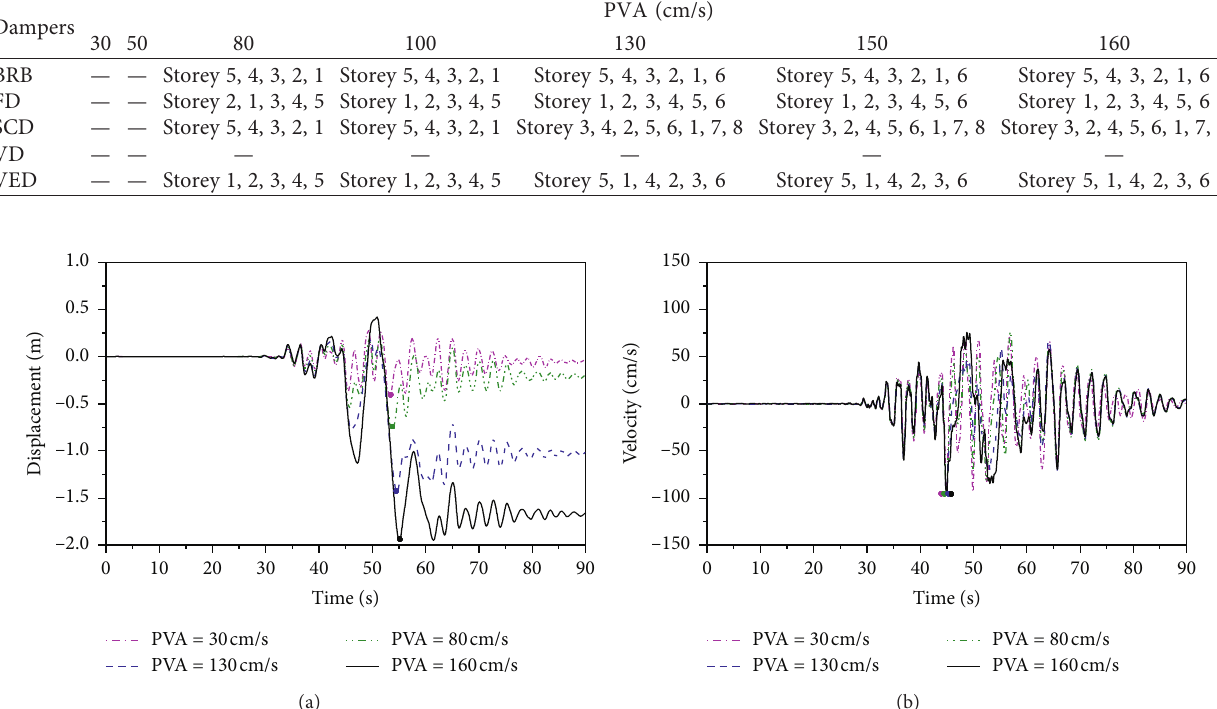
Figure 15: Seismic response of the top storey of the building-VD system subjected to ANEs with different PVAs. (a) Displacement response. (b) Velocity response.